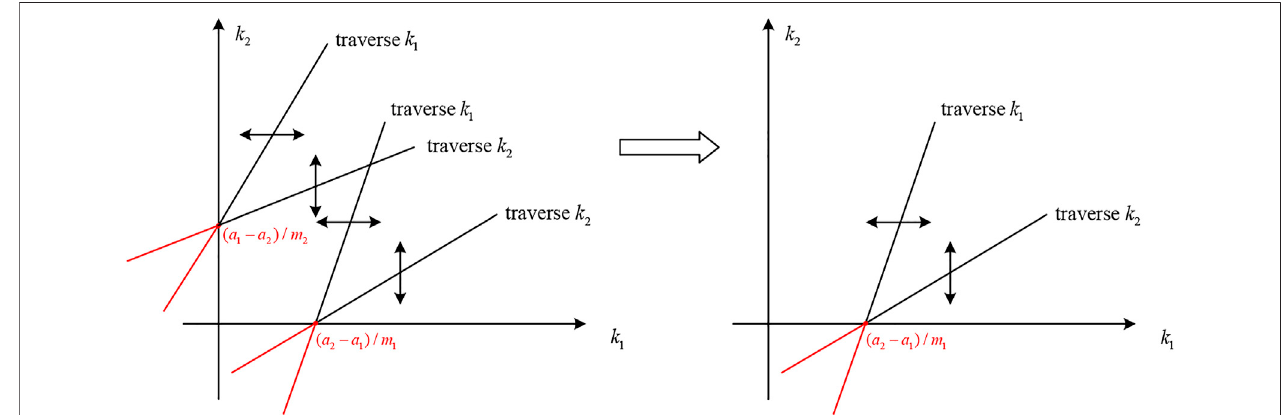
FIGURE 9 | Simpli fi ed schematic diagram of the ambiguity number traversal path.